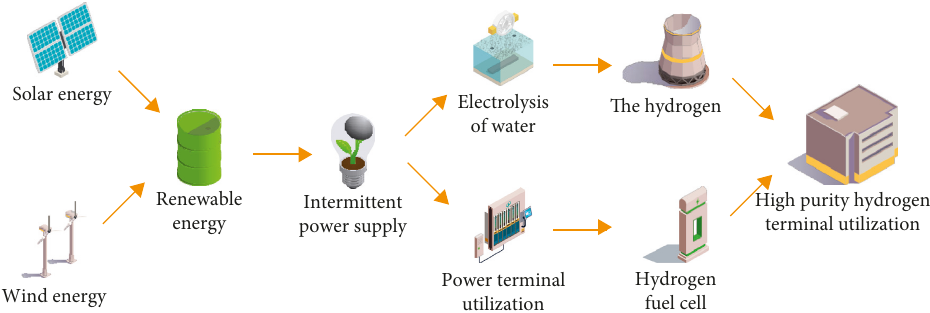
Figure 1: Distributed continuous clean energy supply system with hydrogen production from electrolytic water as the